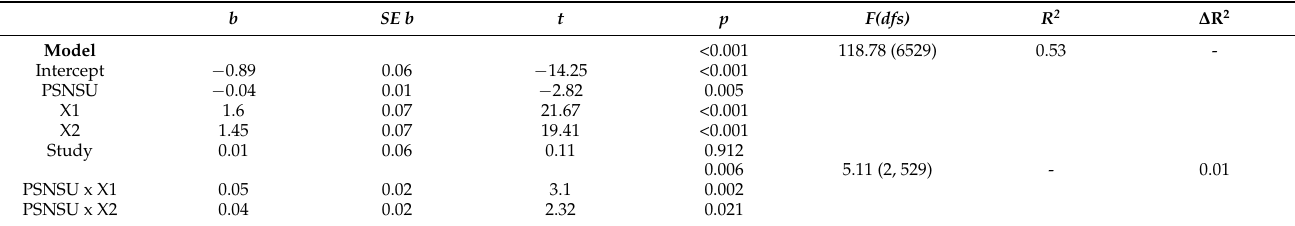
Table 6. Moderation model with Condition, PSNSU, and Their Two-Way Interactions as Predictors of the Direction of Social Comparison.